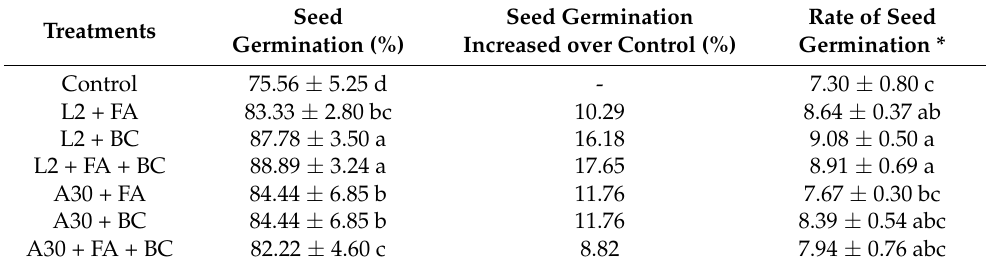
Table 3. Seed germination details of eggplant treated with different treatments. (Mean ± SD). Seed Seed Germination Rate of Seed Treatments Germination (%) Increased over Control (%) Germination * Control 75.56 ± 5.25 d - 7.30 ± 0.80